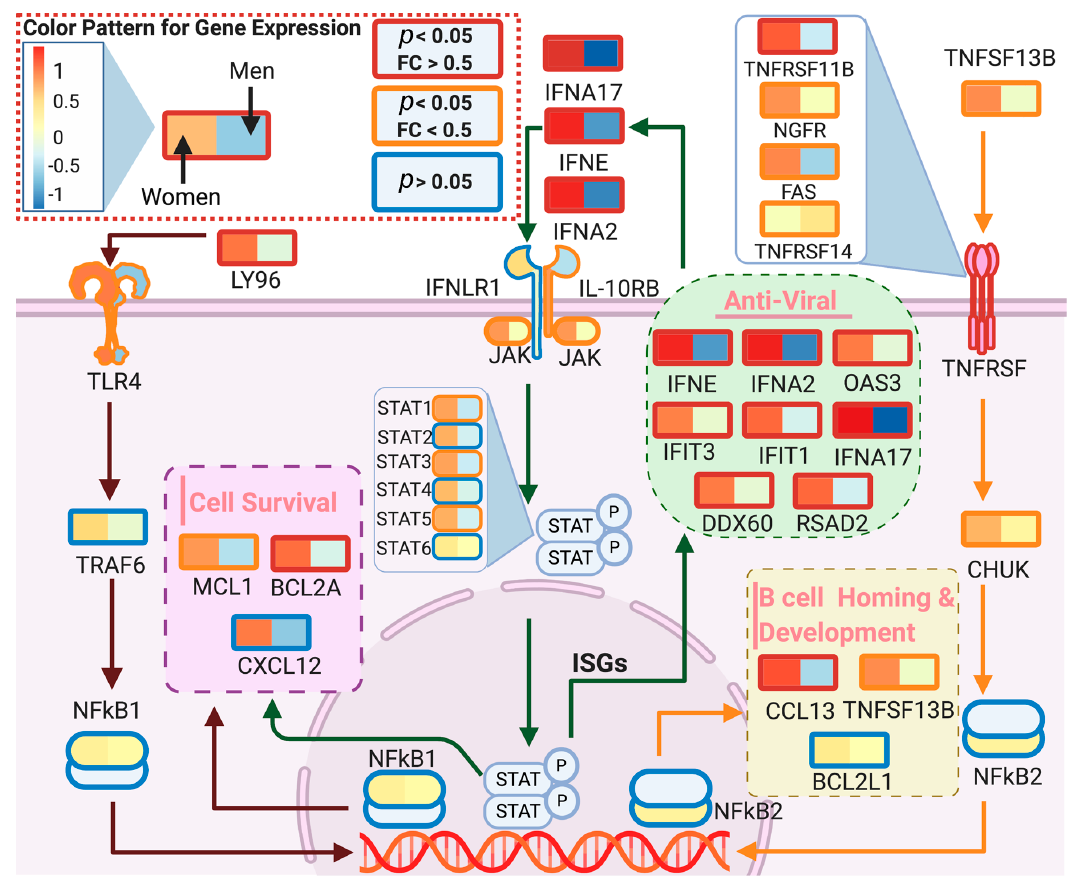
Figure 5. Differential expression of blood interferon genes between sex groups. Boxes represent the mean gene expression value for women ( left ) and men ( right ) groups at blood samples. Old is defined as >60 years old. Box line color indicates the significance level, red: p < 0.05 and fold change (FC) > 0.5; orange: p < 0.05 and FC > 0.5 and blue: p > 0.05 (not significant). The model indicates that females present a more activated antiviral response than males for antiviral interferons, B-cell homing and cell survival pathways. Created with biorender.com.